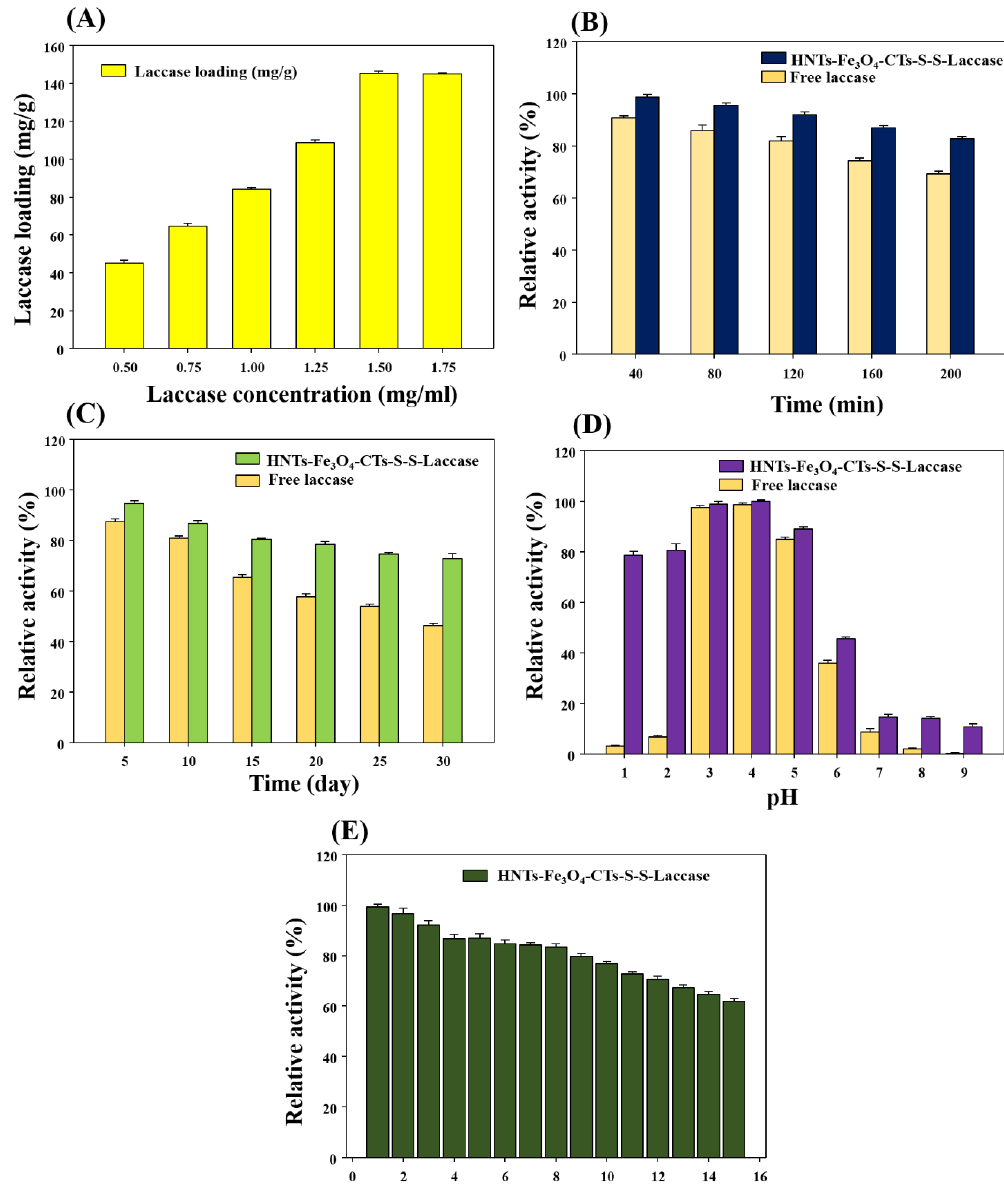
Figure 6. ( A ) Effect of initial laccase concentration on the immobilization on the HNTs-Fe 3 O 4 -CTs-SH, ( B ) temperature stability at 60 °C for 200 min by free laccase and HNTs-Fe 3 O 4 -CTs-S-S-Laccase, ( C ) storage stability for 30 days by free laccase and HNTs-Fe 3 O 4 -CTs-S-S-Laccase, ( D ) pH stabilities free laccase and HNTs-Fe 3 O 4 -CTs-S-S-Laccase, and ( E ) repeated cycle activities of the HNTs-Fe 3 O 4 -CTs-S-S-Laccase.